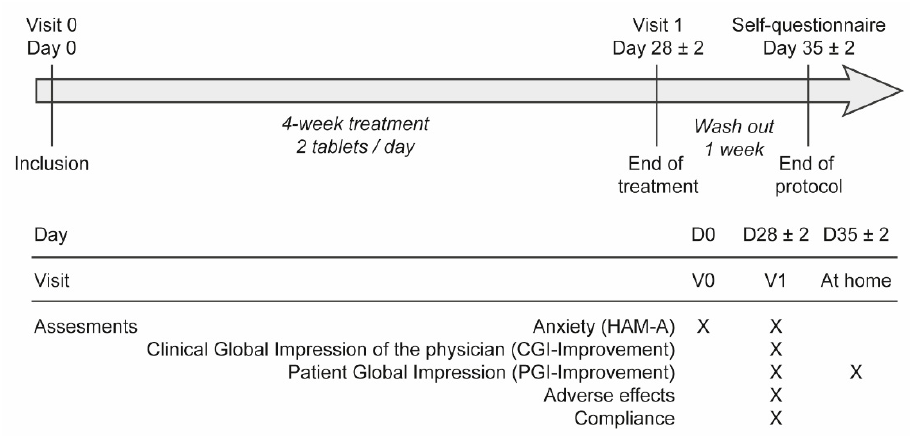
Figure 1. Treatment protocol. The “ × ” indicates the visits during which different tests were adminis- tered to patients. Text in italics refers to the length and treatment phases between the visits.